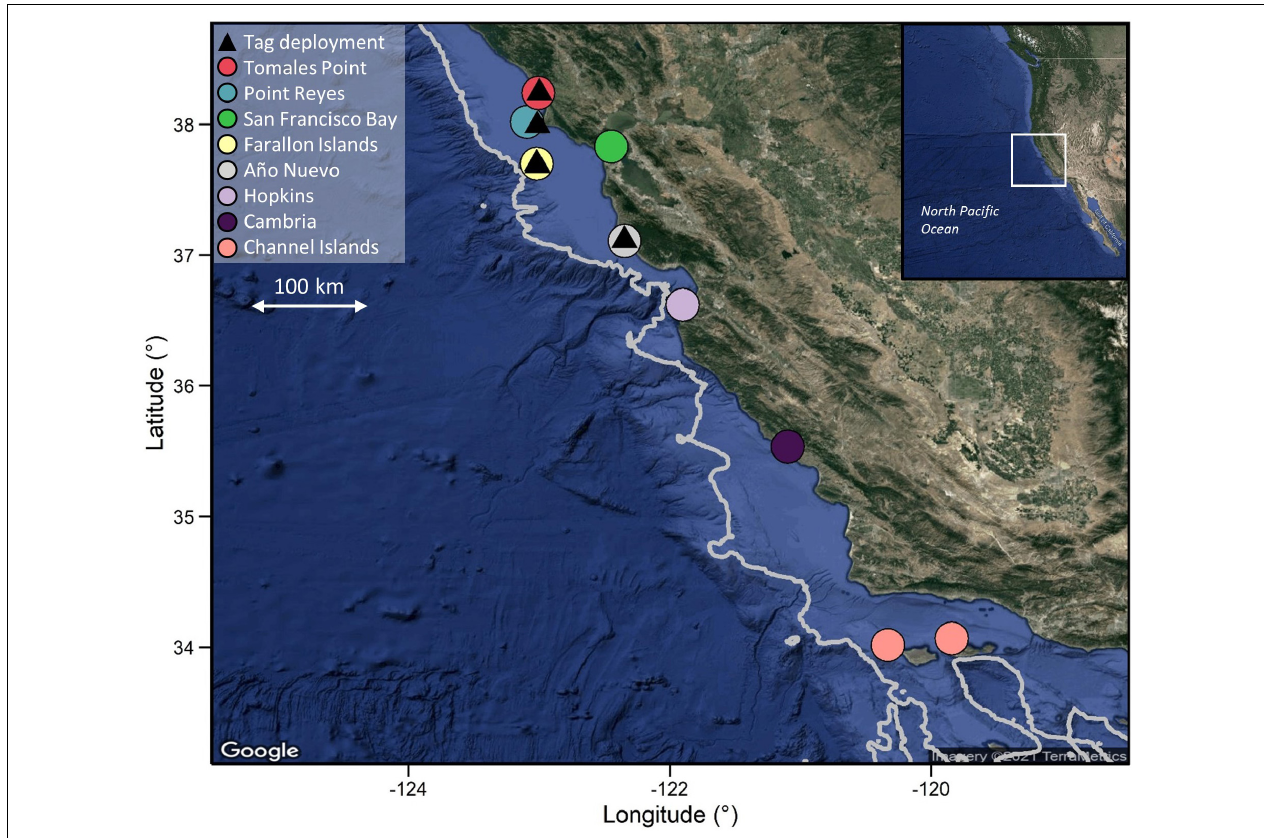
FIGURE 1 | PSAT deployment locations on the Northern Californian coast and locations of acoustic receivers. Depth contour line represents the 1,000 m depth contour. Note that scale varies among maps. Bathymetry data were extracted from the ETOPO1 database using marmap in